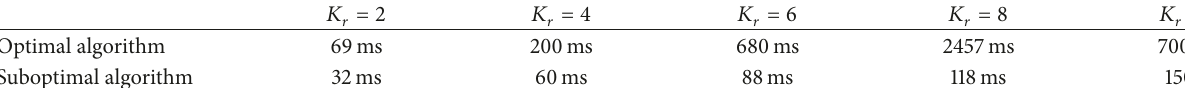
Table 2: Comparison of execution times used by the optimal and suboptimal algorithms.